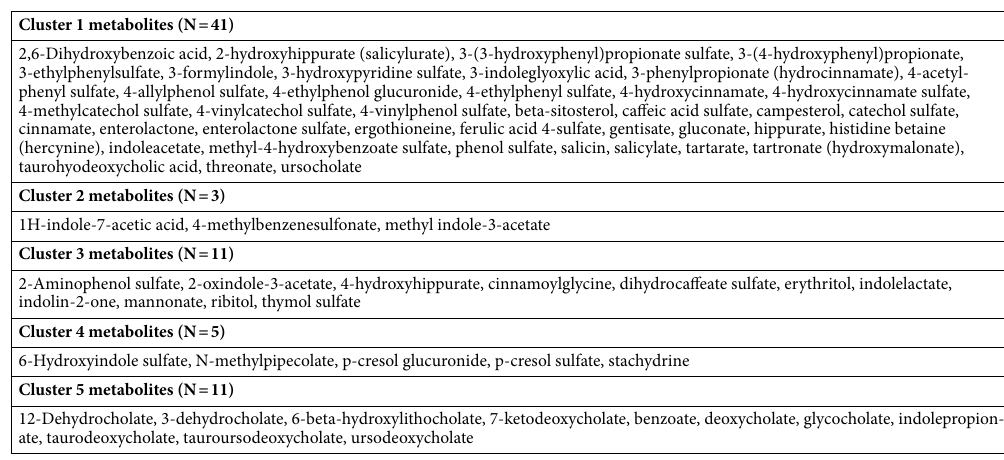
Figure 2. Hierarchical clustering for 813 metabolites in maternal plasma. ( a ) Hierarchical Clustering on Principal Components. Percentage composition of microbial metabolites in the hierarchical clusters of the sample PCA loadings, using Ward’s method. Compounds were defined as microbial-derived (red), endogenous-derived (blue), and unknown identity (green). ( b ) Hierarchical clustering of the sample PCA loadings, plotted against the principle component score for Dimension 1. Plant phenolics were correlated in Cluster 1, and secondary bile acids in Cluster 5; Cluster 3 represented metabolites largely unaffected by alcohol. ( c ) Hierarchical Clustering on Spearman’s Correlation. The microbial-derived metabolites retained their relationships and plant-derived phenolics were correlated in cluster 4, while the secondary bile acids were in cluster 1. The correlation within Clusters 4 and 5 indicate metabolites having an immediate cellular process affected by the alcohol treatment, whereas the former clusters contain metabolites affected more distantly. For ( b ) and ( c ), a positive principal component score indicates the metabolite has increased abundance in response to alcohol; negative scores signify reduced abundance. Sample size is n = 9 control and n = 8 alcohol-exposed dams.